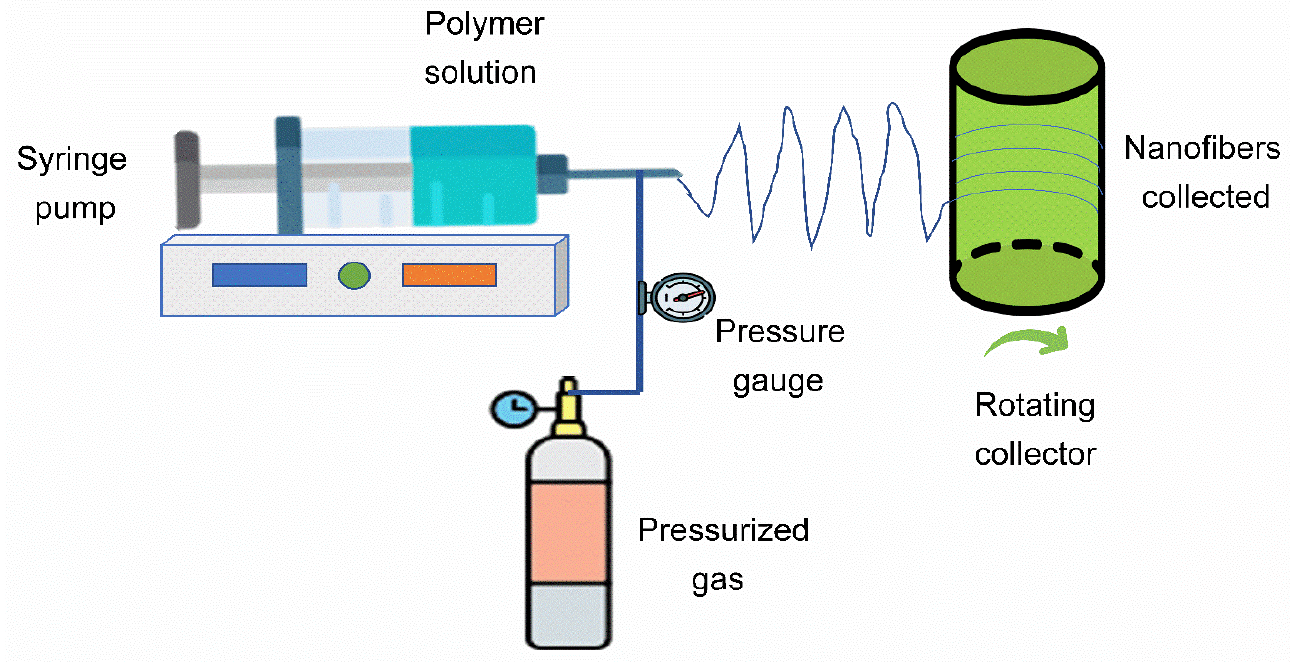
Figure 2. Schematic representation of the SBS system.